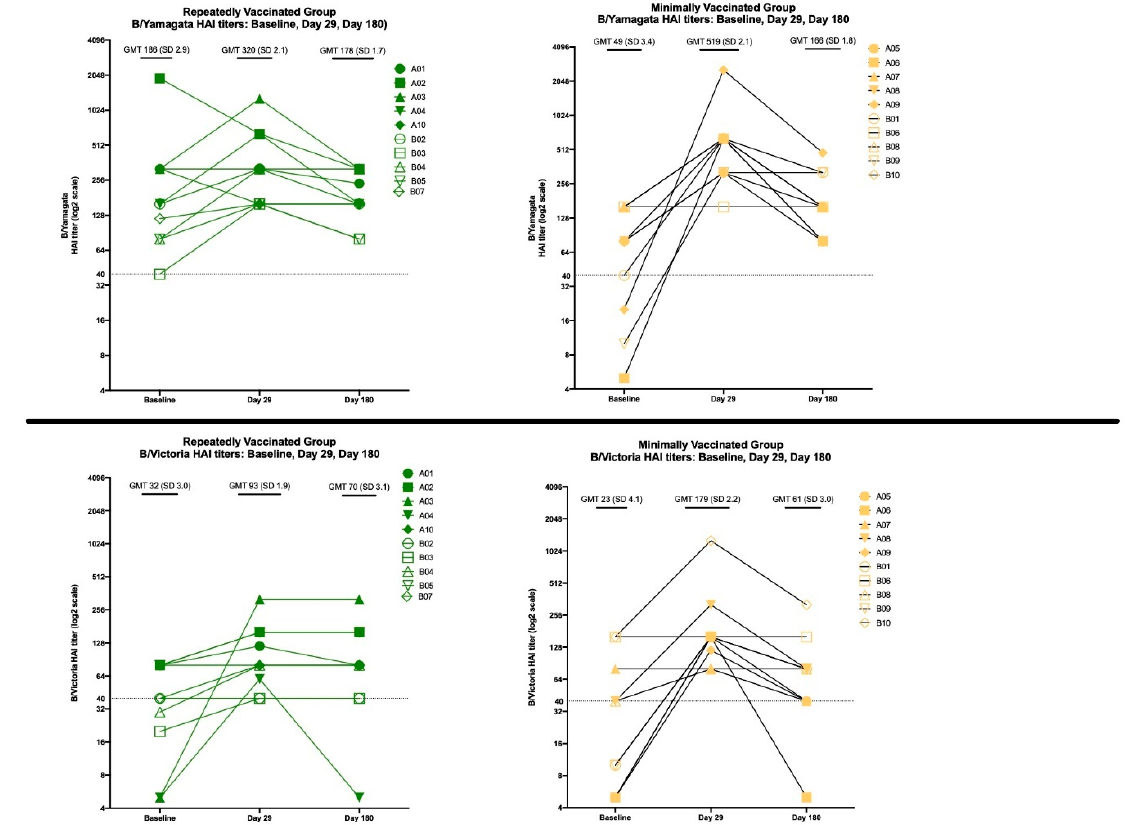
Figure 5. The panels (top to bottom) display the H1N1 HAI, H3N2 HAI, B/Yamagata HAI, and B/Victoria HAI titers for each subject at Baseline, Day 29, and Day 180. Green symbols represent the repeatedly vaccinated subjects, and yellow symbols are the minimally vaccinated group. The closed symbols denote individuals from the H3N2 birth cohort, and the open symbols denote individuals from the H1N1 birth cohort. Geometric mean titer and geometric standard deviation factor are provided. The horizontal dotted lines at 40 represent the HAI titer typically associated with seroprotection.